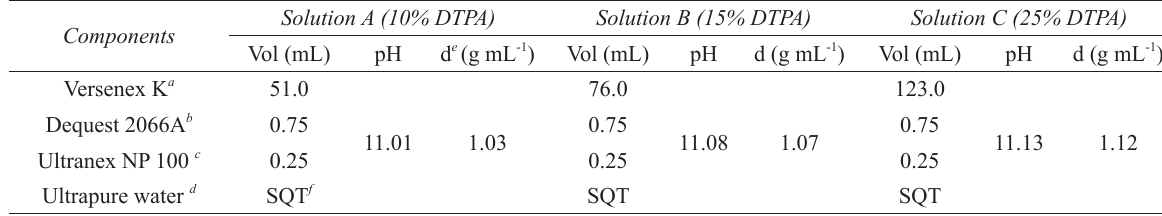
Components of dissolver solution and its respective functions.